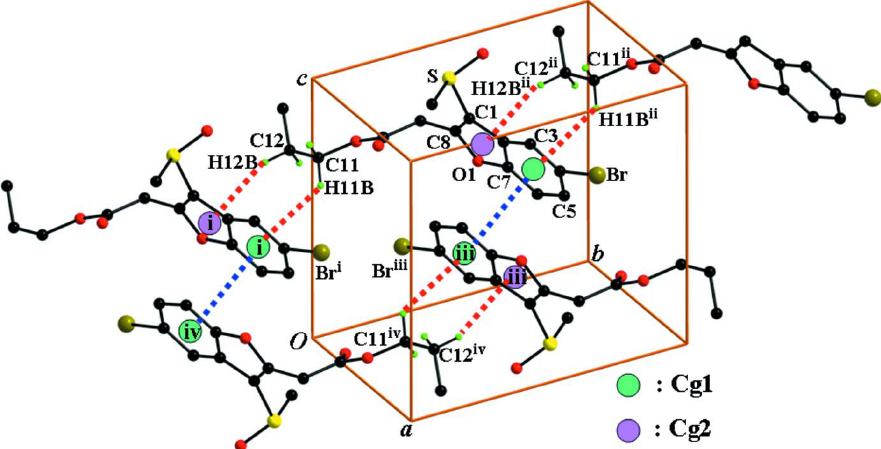
Figure 2 π — π and C—H··· π interactions (dotted lines) in the title compound. Cg denotes the ring centroids. [Symmetry codes: (i) x , y -1, z ; (ii) x , y +1, z ; (iii) - x +1, - y +1, - z +1; (iv) - x +1, - y , - z